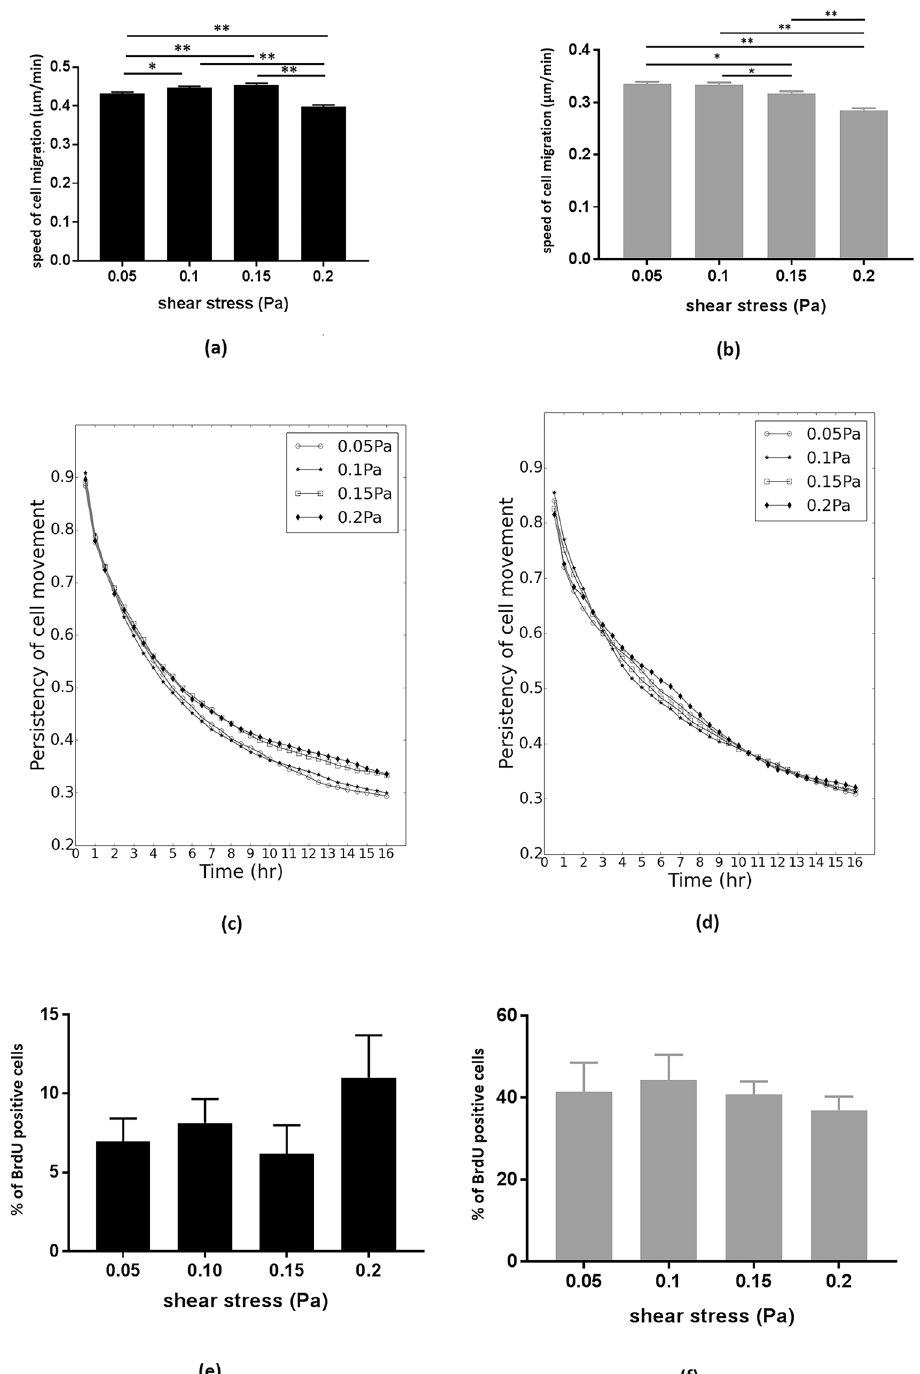
Figure 3. Bar graphs showing the mean migration speed of HUVECs ( a ) and HMEC-1 ( b ) under shear stress of normal (0.05 Pa) and FGR conditions (0.1, 0.15 and 0.2 Pa). Error bars represent the standard error ( * and ** show statistical significance, * p = 0.01, ** p < 0.0001). Line graphs showing the persistency of HUVECs (no significant differences) ( c ) and HMEC-1 (0.05 Pa and 0.1 Pa are significantly less persistent than 0.15 and 0.2 Pa, p < 0.001) ( d ) under shear stress. Bar graphs showing the proportion of HUVECs ( e ) and HMEC-1 ( f ) that incorporated BrdU over a 4 hr